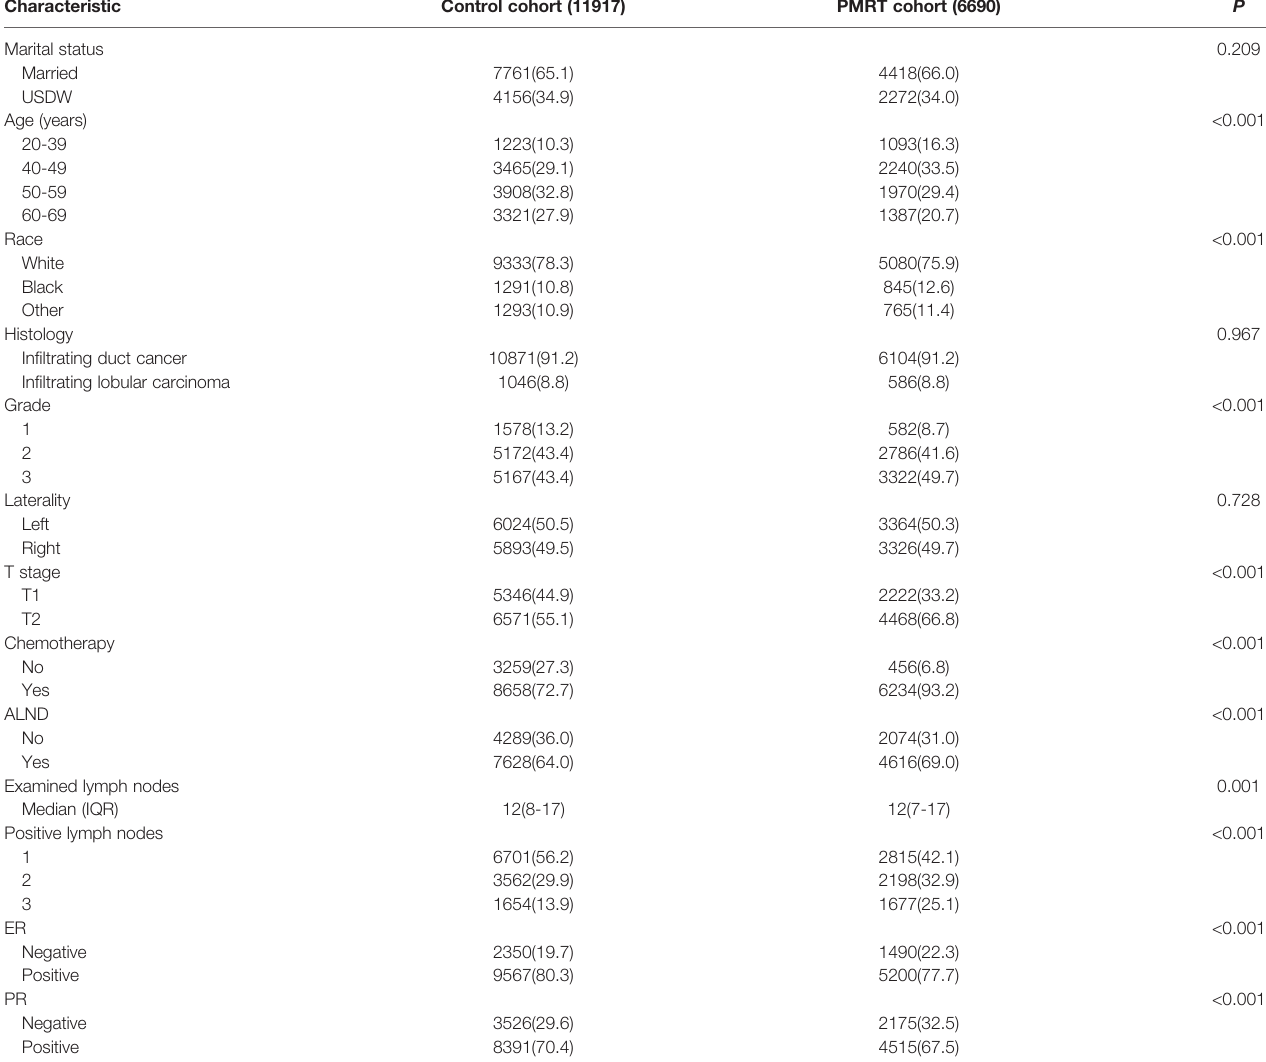
TABLE 1 | Demographic and clinicopathologic features of patients between the control cohort and PMRT cohort in T-2 breast cancer with 1-3 positive lymph nodes.